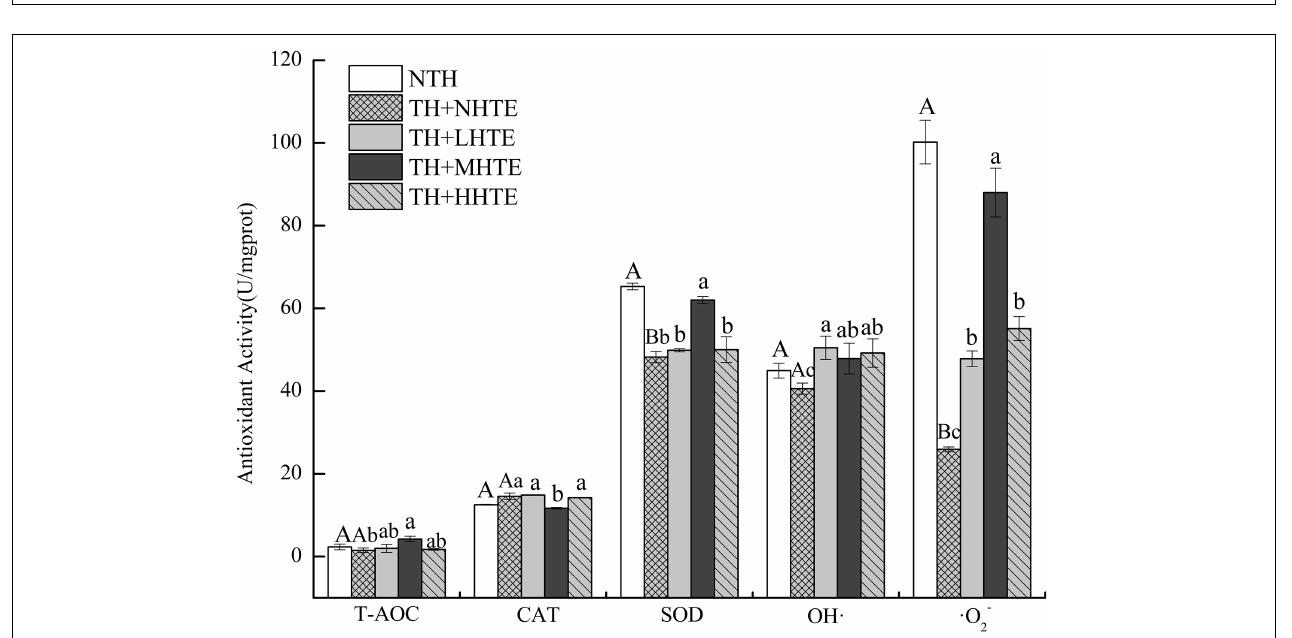
FIGURE 7 | Total antioxidant capacity (T-AOC), catalase (CAT) activity, superoxide dismutase (SOD) activity, and the inhibition for hydroxyl radical (OH · ) and superoxide anion ( · O 2 − ) of female flies under thermal stress fed a diet containing hsian-tsao extract (HTE) of low, medium, or high concentrations (TH + LHTE, TH + MHTE, or TH + HHTE) with thermal hardening (TH) and a non-HTE diet with or without TH (TH + NHTE, NTH) (90 female flies per group, 30 per replicate). Data show mean ± SD. Different uppercase letters indicate significant differences between NTH and TH + NHTE, while different lowercase letters indicate significant differences between groups with thermal hardening (LSD test after one-way ANOVA, P <